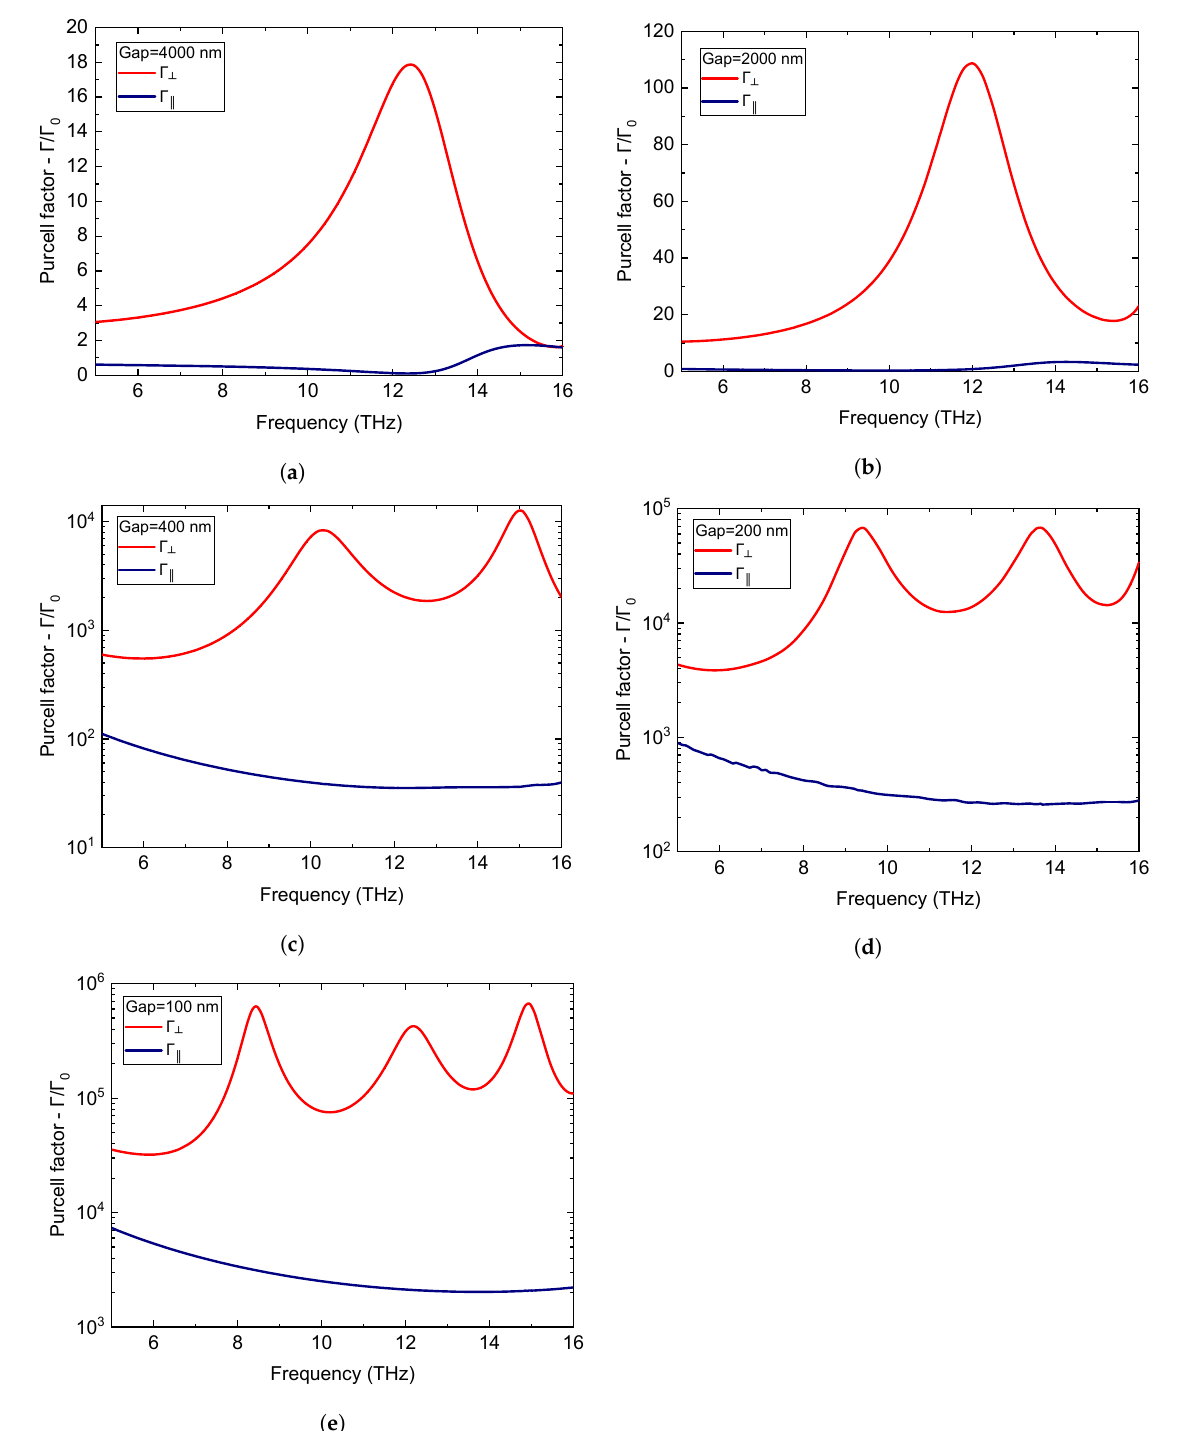
Figure 4. The Purcell factors for a dipole which is normally and tangentially oriented with respect to the surfaces of Bi 2 Se 3 2 µ m microspheres, as a function of EM mode frequency of the QE and gap distance. ( a ) Gap = 4000 nm, ( b ) Gap = 2000 nm, ( c ) Gap = 400 nm, ( d ) Gap = 200 nm, ( e ) Gap = 100 nm. The Purcell factor, as in the case of Bi 2 Te 3 microspheres, increases for dipole moments with direction perpendicular to the surfaces of the microspheres, while for dipole moments parallel to the surfaces of the microspheres, the Purcell factor decreases. The polaritonic resonances are shifted towards lower frequencies compared to the Bi 2 Te 3 dimer system, because the maximization of the difference between the decay rates Γ ⊥ , Γ (cid:107) occurs